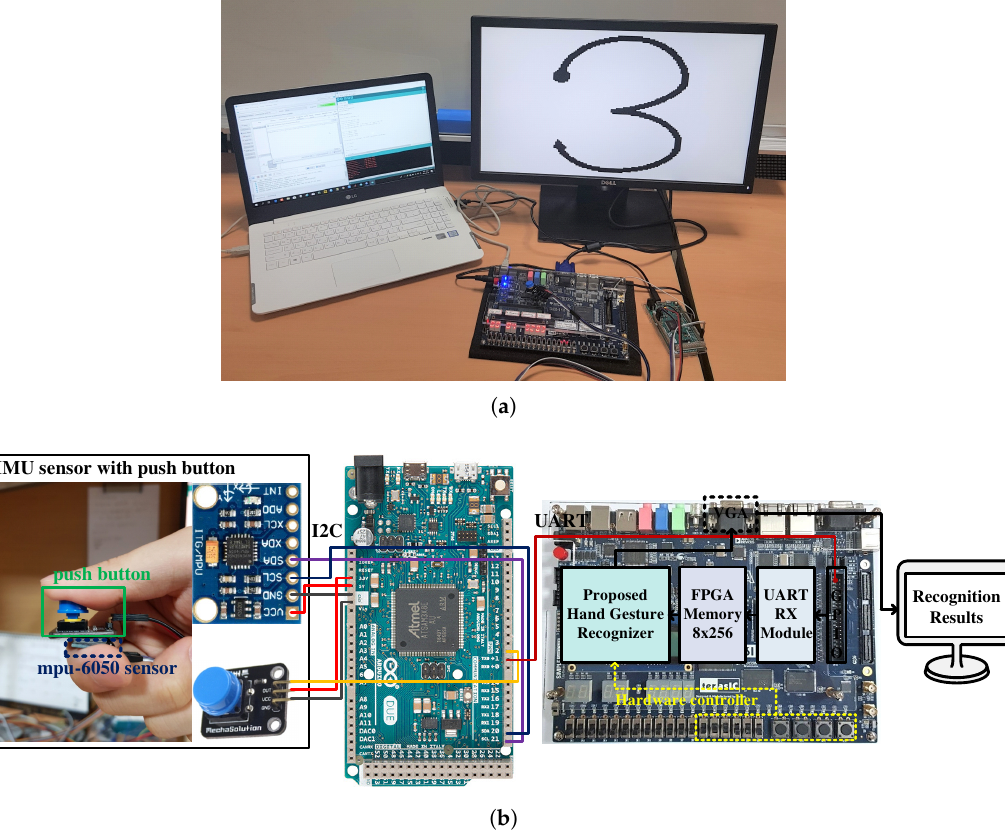
Figure 7. HGR test platform: ( a ) photograph of the test platform; ( b ) configuration of the test